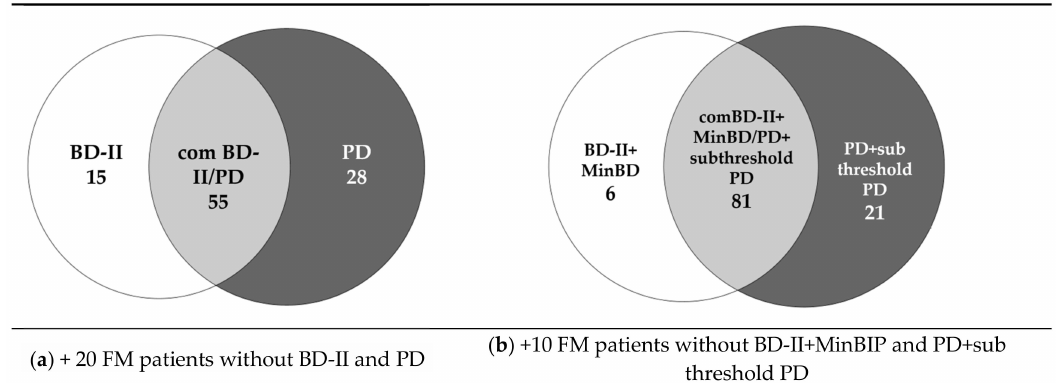
Figure 2. The temporal sequencing of threshold BD, PD, and FM.